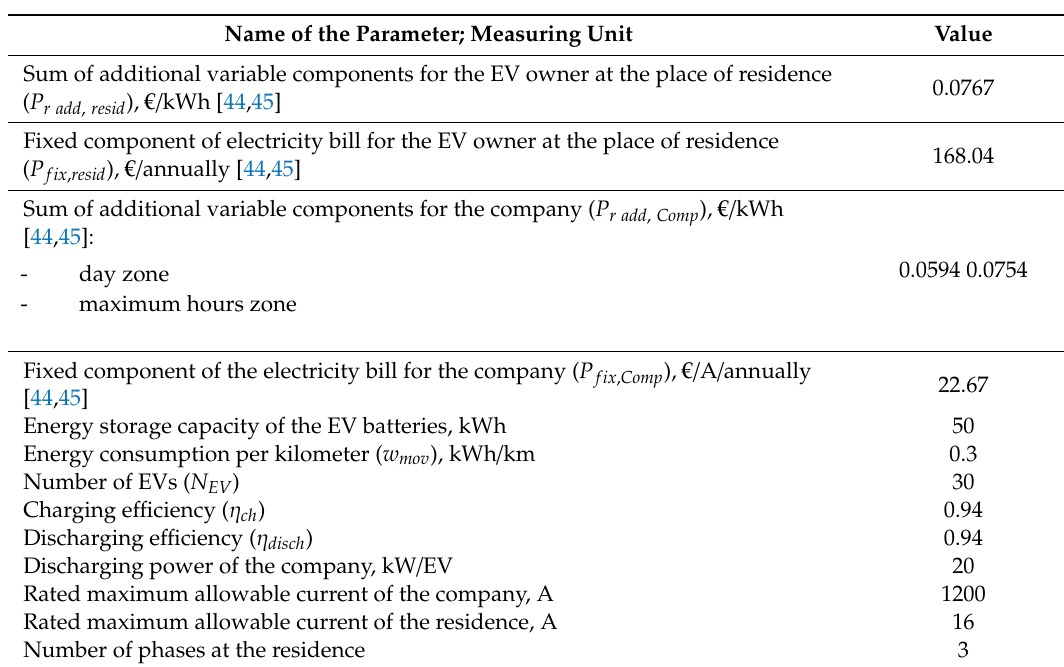
Table 1. The key